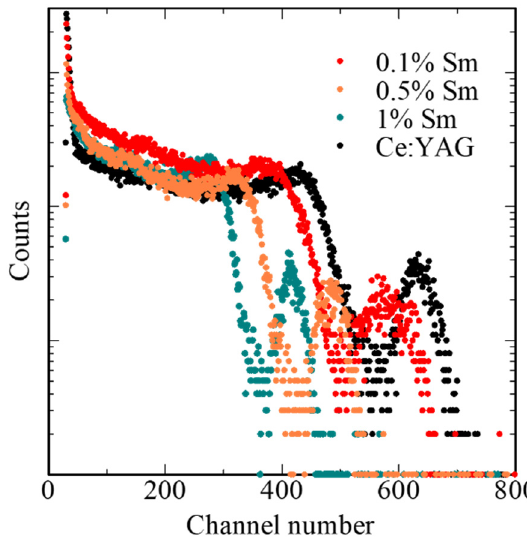
Figure 6. Pulse height spectra of 137 Cs γ -rays.